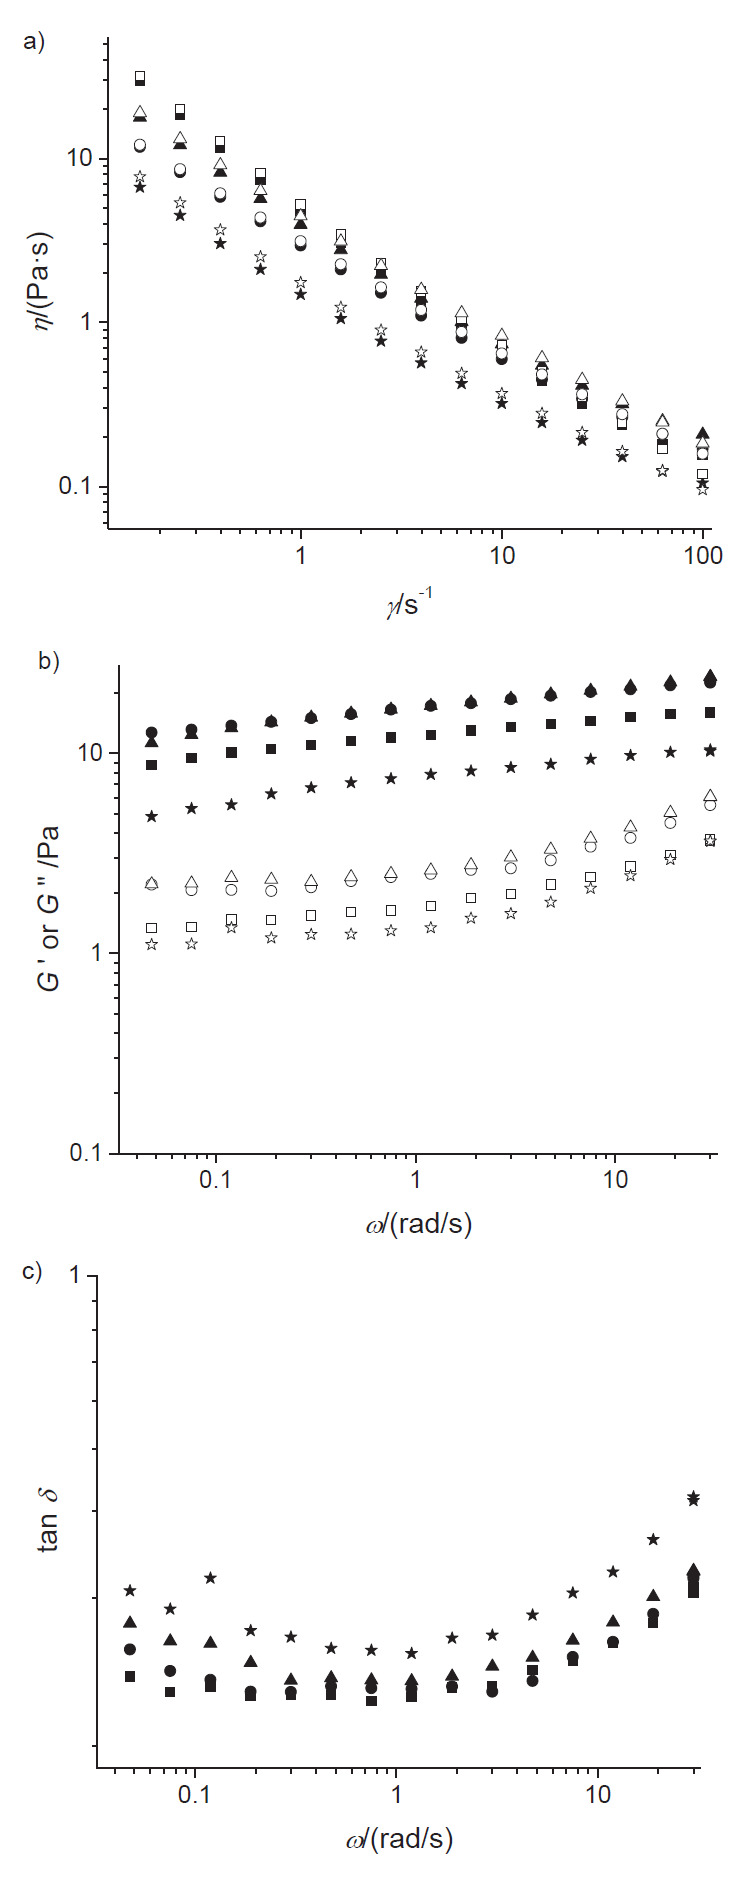
The curves obtained for: a) apparent viscosity for downward (closed symbols) and upward (open symbols) shear rate ramps, b) storage G' (closed symbols) and loss G" (open symbols) moduli as functions of frequency, and c) loss tangent, tan (δ) of the emulsions: O14S74P360 (w(buriti oil)=14%, w(SPI)=74% in wall material and p=360·105 Pa) (squares), O26S56P360 (w(buriti oil)=26%, w(SPI)=56% in wall material and p=360·105 Pa) (circles), O26S74P240 (w(buriti oil)=26%, w(SPI)=74% in wall material and p=240·105 Pa) (triangles), and O26S74P360 (w(buriti oil)=26%, w(SPI)=74% in wall material and p=360·105 Pa) (stars)